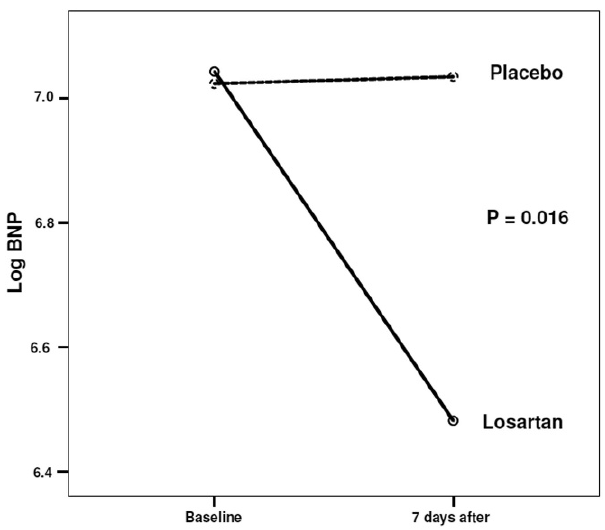
Figure 1 - BNP evolution according to losartan or